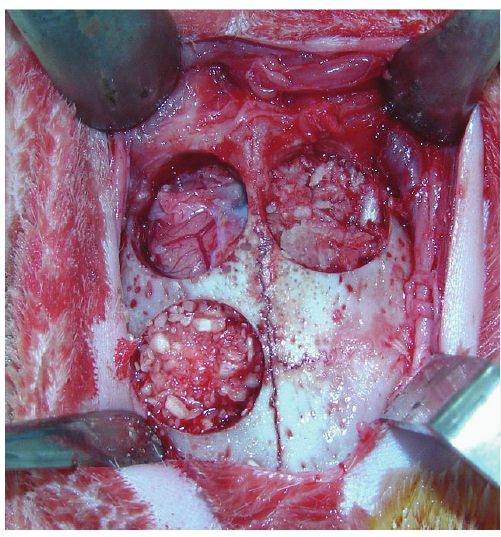
Figure 1: Surgical defects on rabbit calvarium filled with test materials. One defect was left unfilled (upper right), one filled with collected particulate autogenous bone (upper left), and the third defect was filled with the new bovine dentin bone substitute (lower